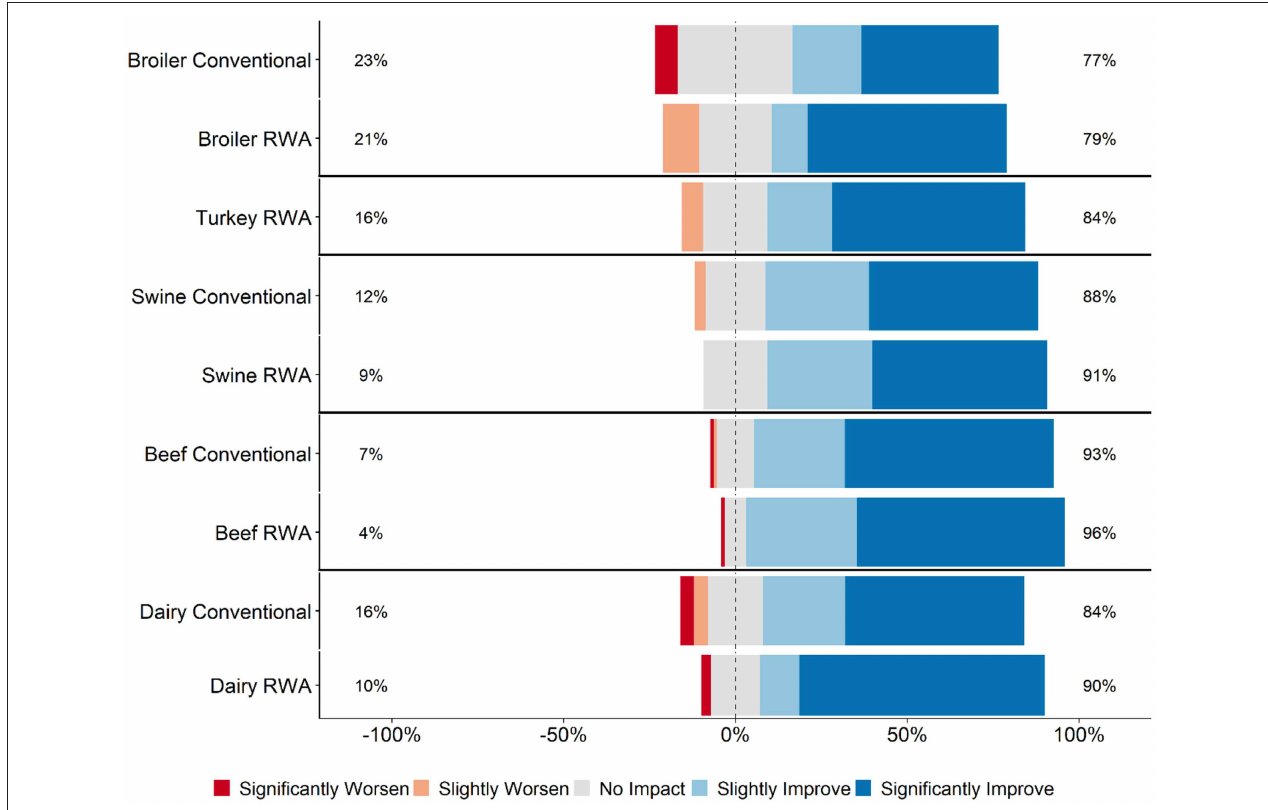
FIGURE 4 | Respondents’ opinion about customer perception regarding the impact of RWA production on food safety. Five-item Likert scale reporting respondents’ opinion, stratified by commodity and RWA experience.